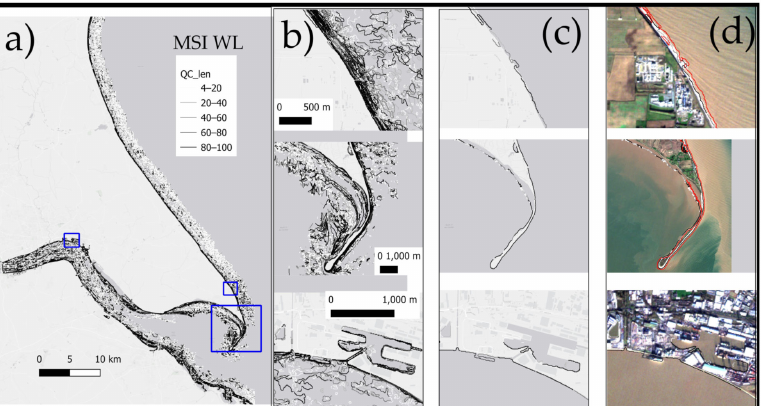
Figure 8. Waterlines and shorelines derived from Sentinel 2 for period November 2017 to June 2020 at the Spurn Head study area; ( a ) all waterlines in gray scale graded by value of QC_len; ( b ) zoom of three different areas over a Light Gray Canvas Base map; ( c ) zoom to same areas shown in b but now with a single waterline extracted from image dated 11:13 UTC 3 December 2019 in grey scale; ( d ) zoomed view with S2 image taken during high tide at 11:13 UTC 3 December 2019 as a base map and shoreline MSL in red in addition to waterline in grey scale. Source of Light Gray Canvas Base map: Esri, HERE, Garmin, © OpenStreetMap contributors, and the GIS user community.